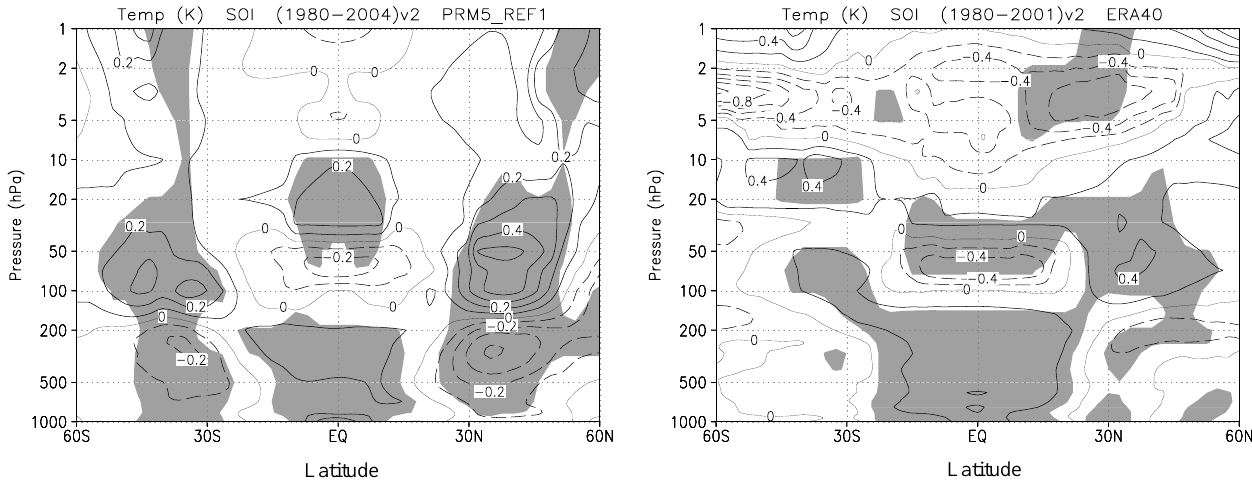
Fig. 20. Latitude-pressure cross sections of the annual average ENSO signal of zonal-mean temperature in K per − 1 standard deviation of SOI between 60 ◦ S and 60 ◦ N for the simulation (left) and observation (ERA-40) (right). Contour interval is 0.1 for the simulation, and 0.2 for ERA-40. Shading denotes the 95% confidence level (t-test).